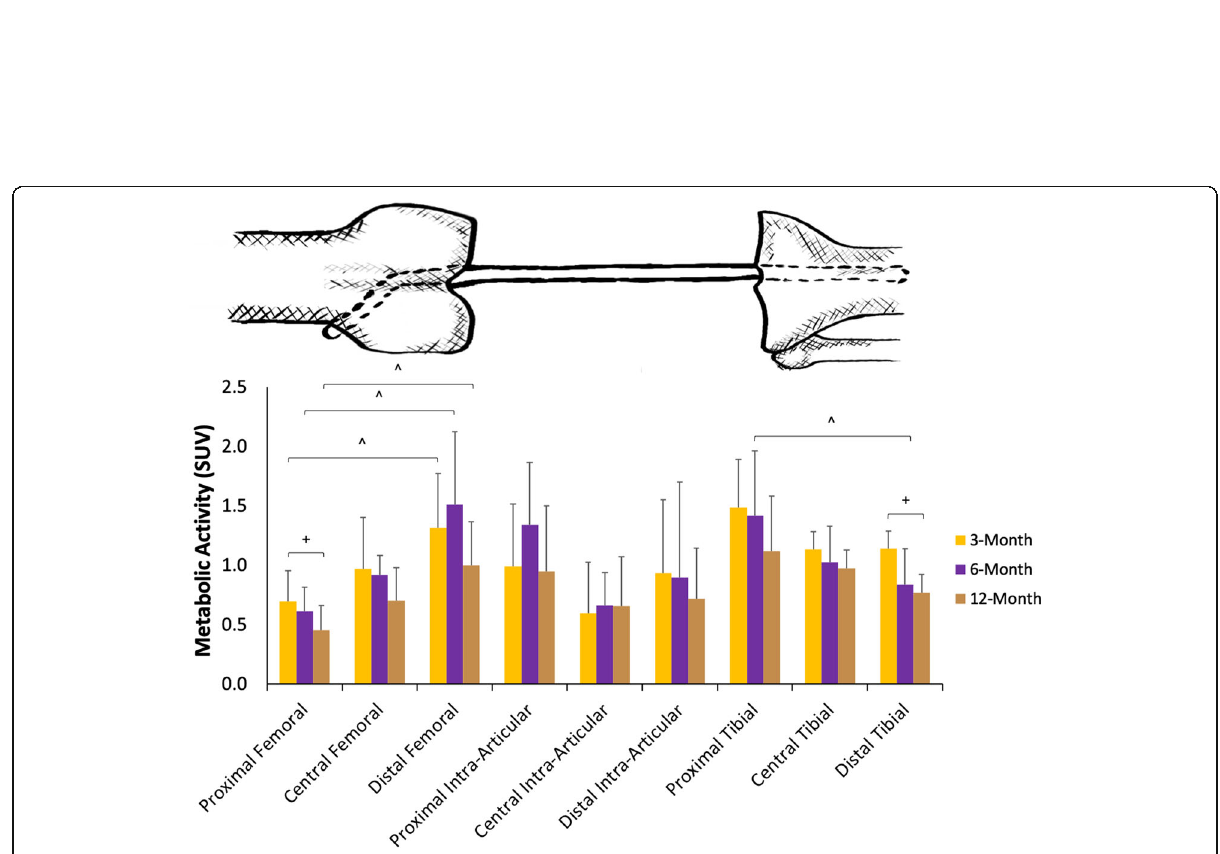
Fig. 4 Subregion SUV. Graph displaying the metabolic activity (y-axis) of the femoral tunnel, intra-articular graft, and tibial tunnel split into proximal, central, and distal subregions (x-axis). An exaggerated sketch of the subregions is overlaid above to correlate with the subregions on the x-axis. The metabolic activity of the subregions is differentiated into the three-month (yellow), six-month (purple), and 12-month (brown) time periods. ^ and + denote significance ( p < 0.05) between the distal and proximal subregions and the six-month and 12-month time-periods,